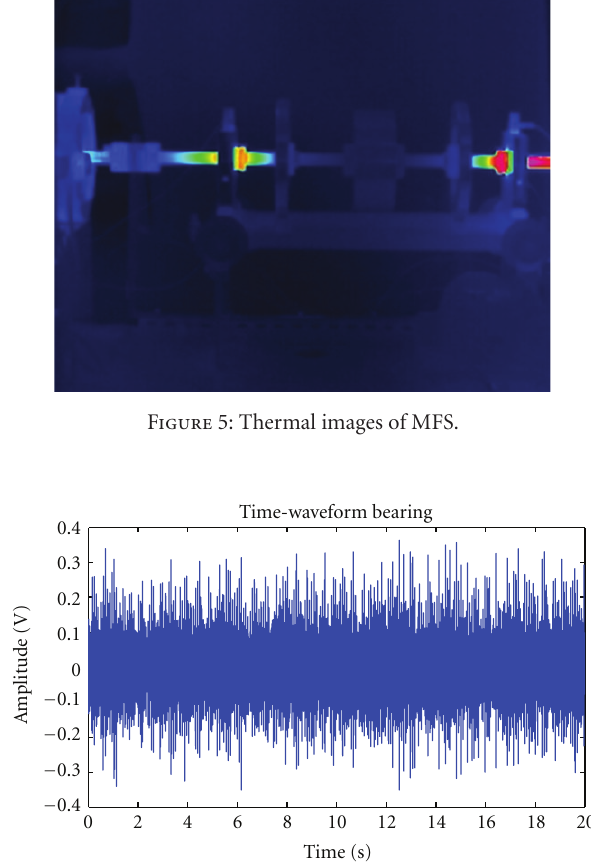
Figure 6: Vibration signal of faulty